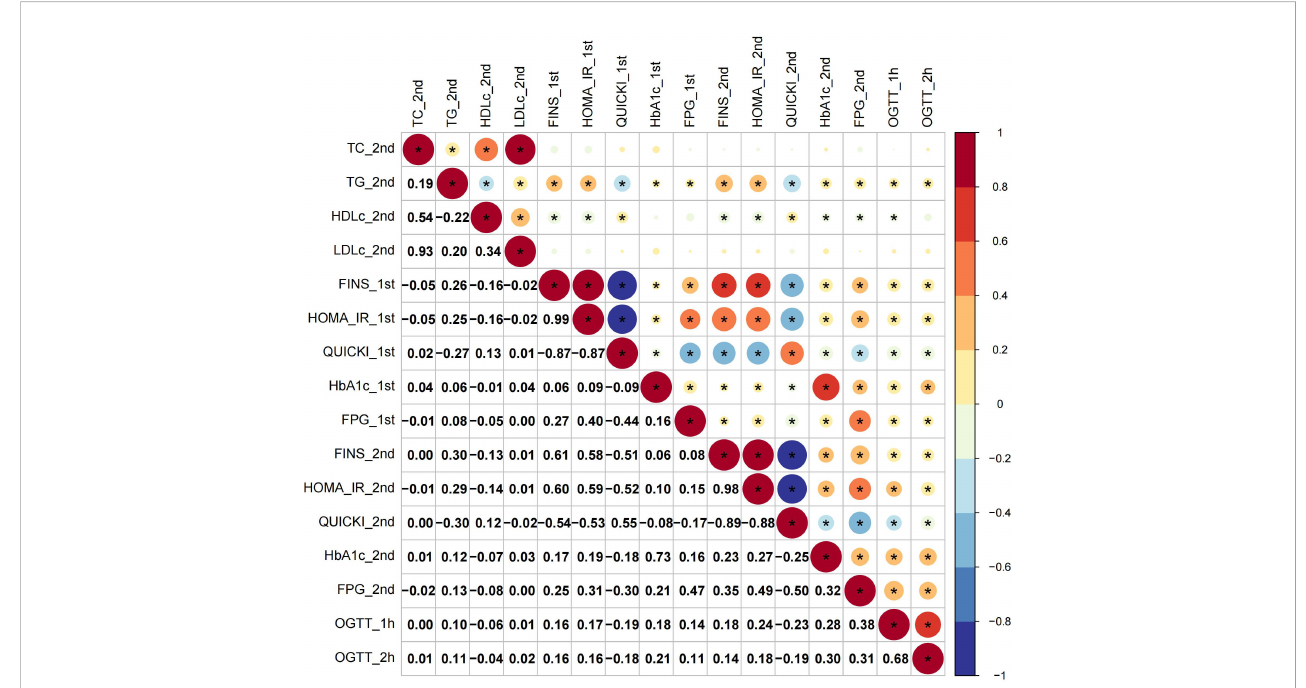
FIGURE 2 Correlations of second-trimester lipid pro fi les with glucose metabolism and insulin